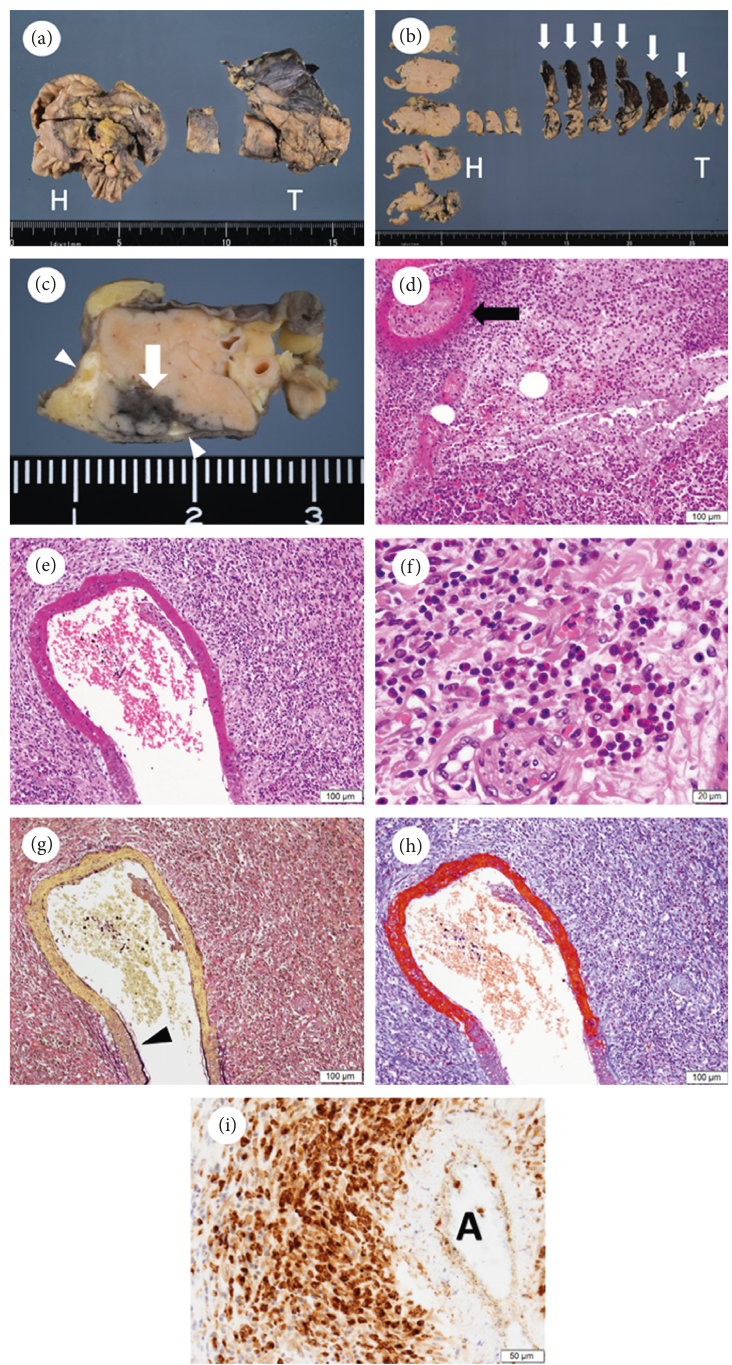
Figure 2: (a) Gross appearance of the pancreas. (b) Gross view of all sections of the pancreas. The arrows indicate hemorrhage spreading from the pancreatic body and tail to the retroperitoneal adipose tissue. (c) Gross view of a section of the pancreatic body. The arrow and arrowheads indicate the hemorrhage and fat necrosis, respectively. (d) Hematoxylin and eosin- (H&E-) stained figure of acute pancreatitis ( × 100). The arrow indicates necrotizing vasculitis of a small-sized artery. (e) H&E-stained figure of necrotizing vasculitis of a small-sized artery ( × 100). (f) Higher magnification ( × 400) of the adventitia of the small artery seen in subfigure (e). Infiltration by numerous eo- sinophilic cells is observed. (g) Elastica van Gieson-stained figure of a small-sized artery ( × 100). The arrowhead indicates the internal elastic lamina. The internal elastic lamina disappears in the upper part of the small-sized artery. (h) Masson’s trichrome-stained figure of the small- sized artery ( × 100). Fibrinoid necrosis is accentuated by the red staining of Masson’s trichrome stain. (i) Immunohistochemical staining indicates that the numerous infiltrating cells around the small-sized artery are CD163-positive histiocytes ( × 200). H and T in (subfigures a and b) indicate the head and tail of the pancreas, respectively. A: artery. Scale bars � 100 μ m (d, e, g, and h), 20 μ m (f), and 50 μ m